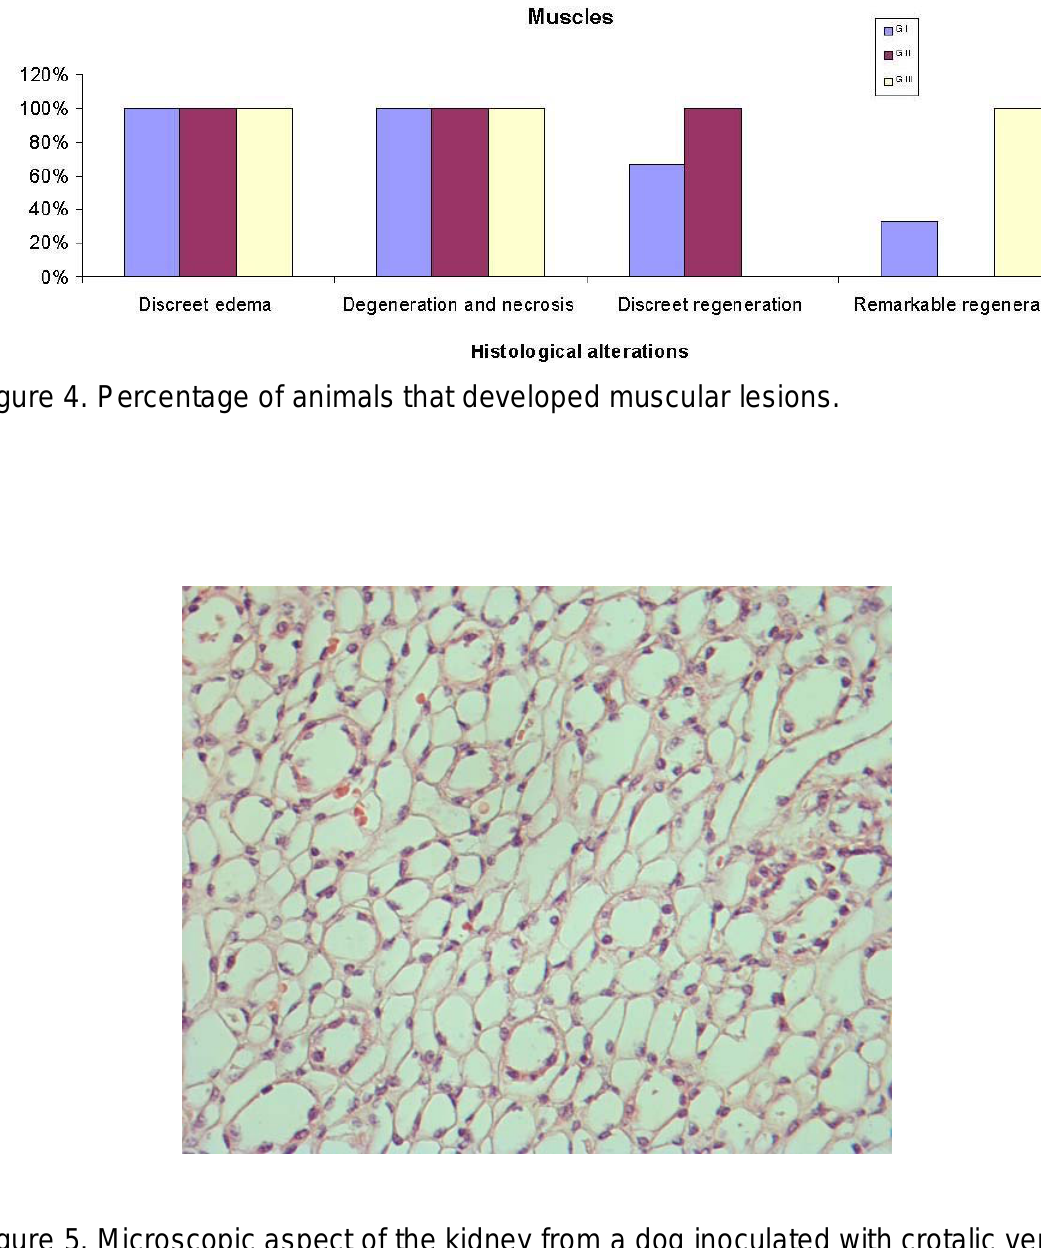
Figure 5. Microscopic aspect of the kidney from a dog inoculated with crotalic venom, showing tubular degeneration (HE,